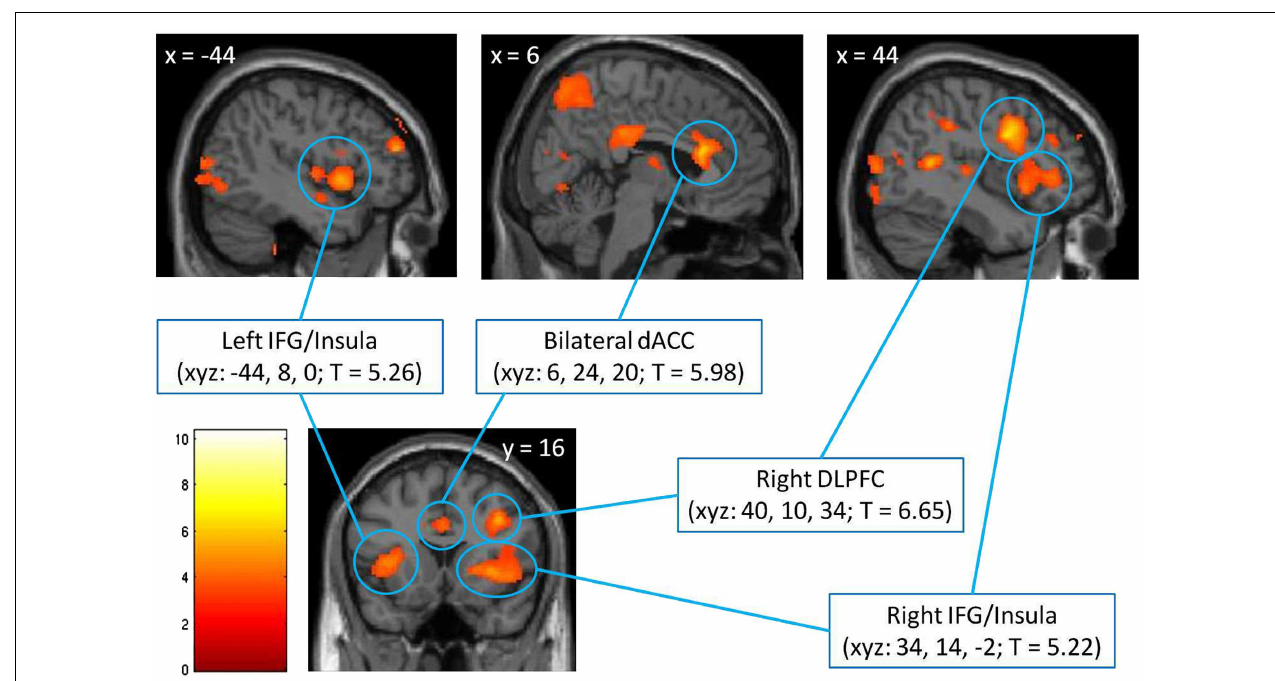
clusters are localized using Montreal Neurological Institute (MNI) coordinates of left/right ( x ), anterior/posterior ( y ), and superior/inferior ( z ), respectively, and are shown against the MNI anatomical brain template.The scale represents t values. dACC, dorsal anterior cingulate cortex; DLPFC, dorsolateral prefrontal cortex; IFG, inferior frontal